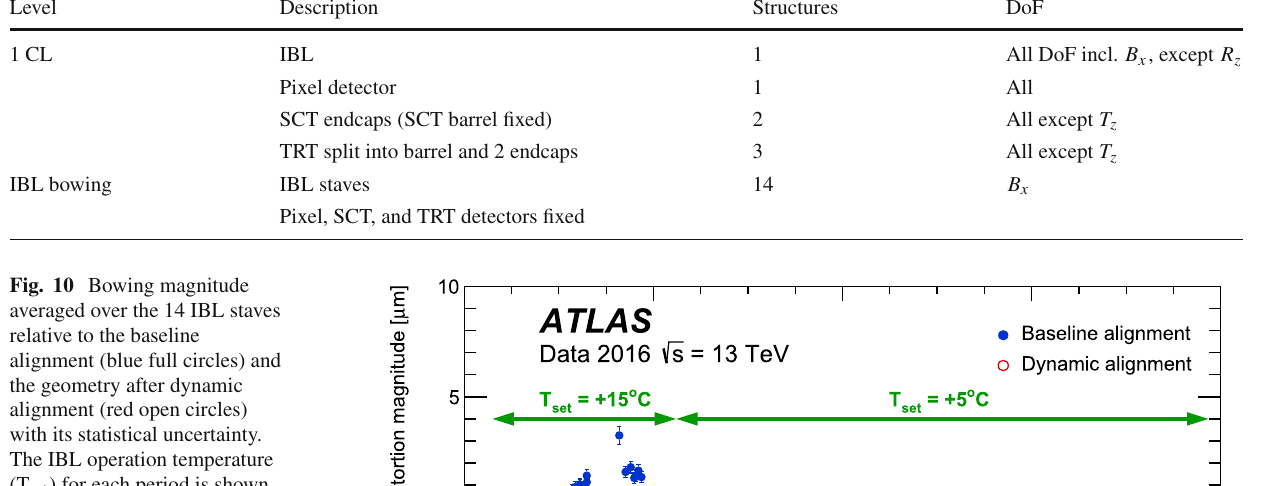
Table 3 Typical alignment configurations used throughout Run 2 data taking to derive dynamic alignment corrections